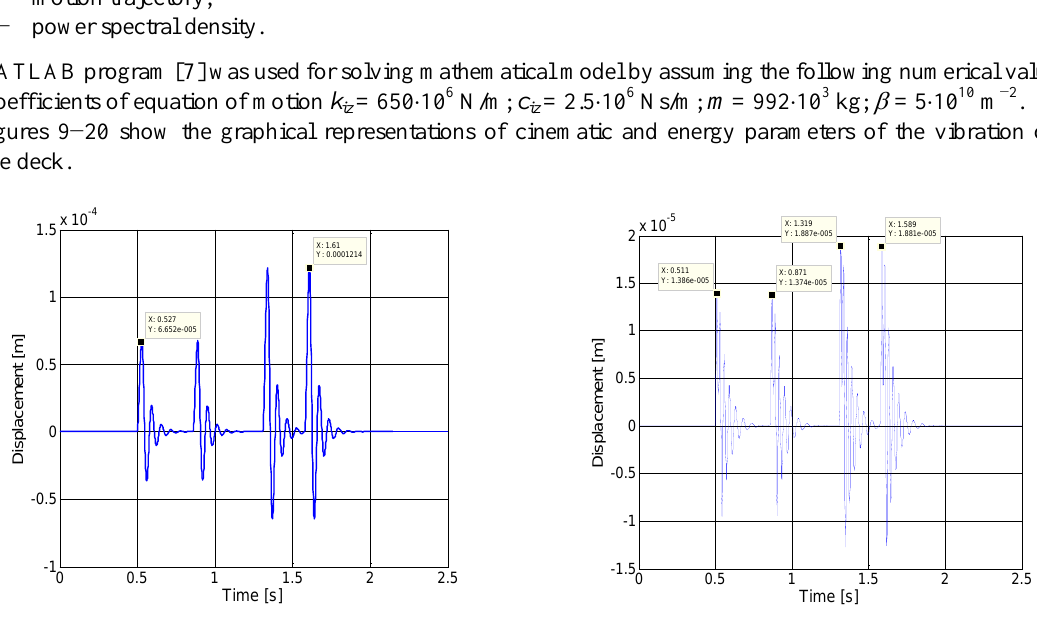
Fig. 9. Displacement on mass m: Linear case. Fig. 10. Displacement on mass m: Nonlinear